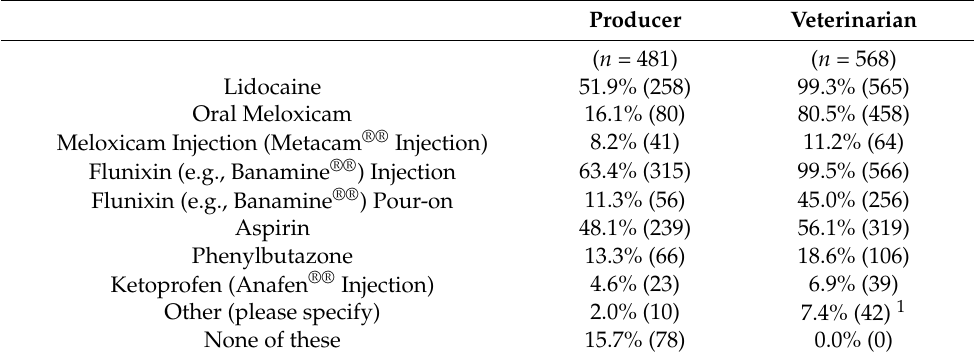
Table 2. Survey respondents ( n = 1066) on pain drugs that they have knowledge and feel comfortable using based on role